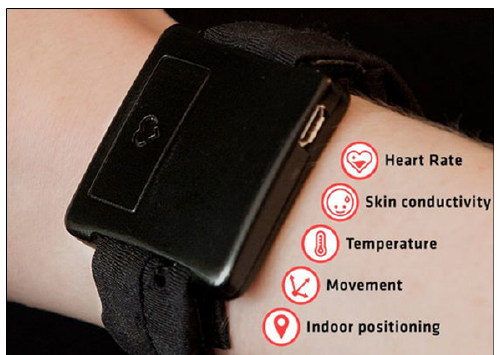
Figure 11. Empatica E4 wristband physiological signal monitoring